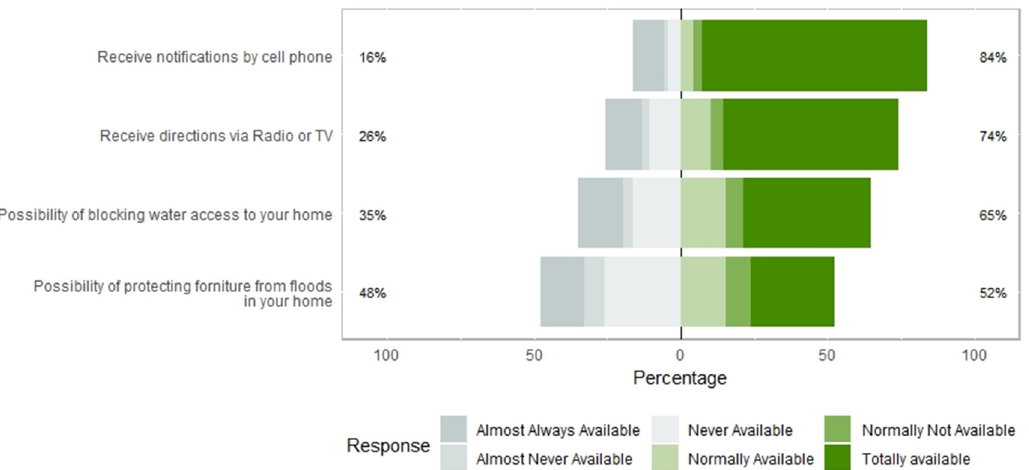
Figure 7. Centered bar plot generated with Likert with response distributions grouped by perceived possibility of blocking water access to homes, receive directions via radio/TV/cell phone and to protect furniture during a flash flooding event.